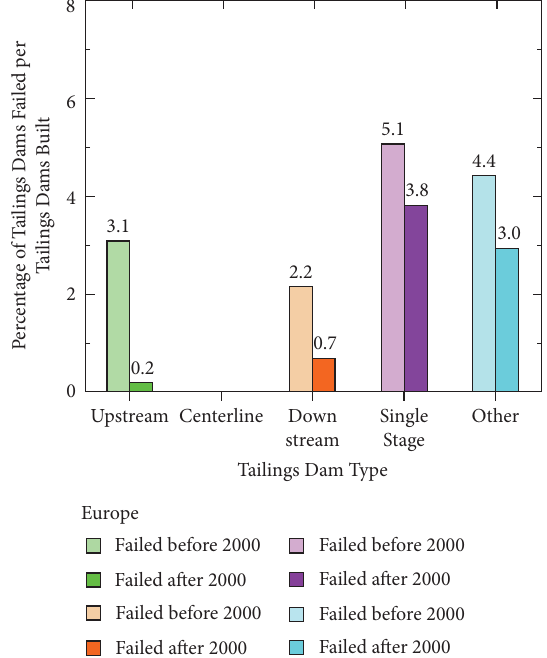
Figure 8: Percentage of tailings dams failed per tailings dams built in Europe, before and after 2000, according to dam type (data from GRID-Arendal [25] and Bowker